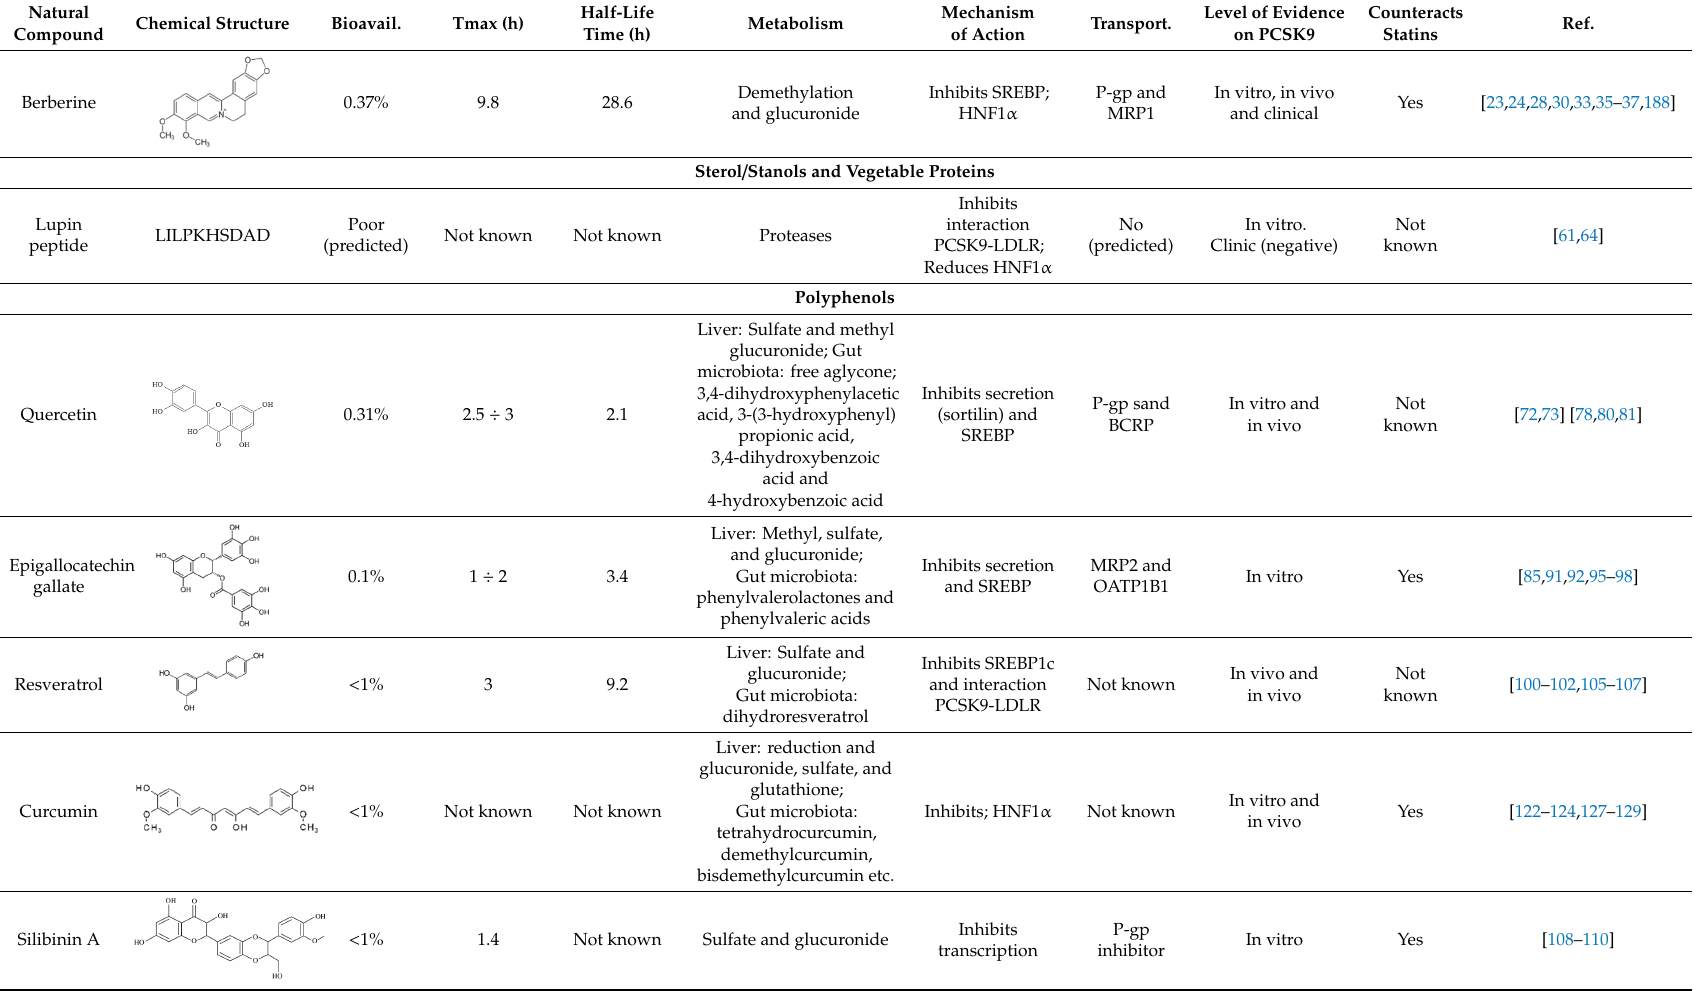
Table 1. Pharmacokinetic and pharmacodinamic characteristics of natural compounds affecting PCSK9.